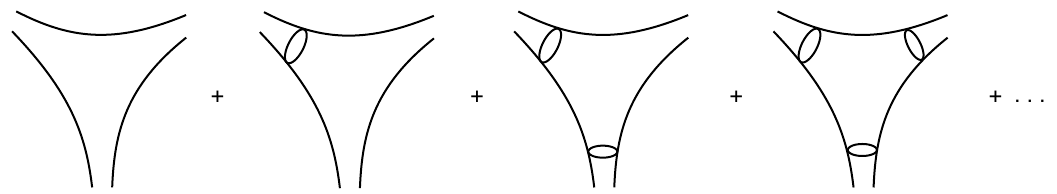
Figure 7. The second set of diagrams (planar diagrams) contributing to the six-point function at order 1 =N 2